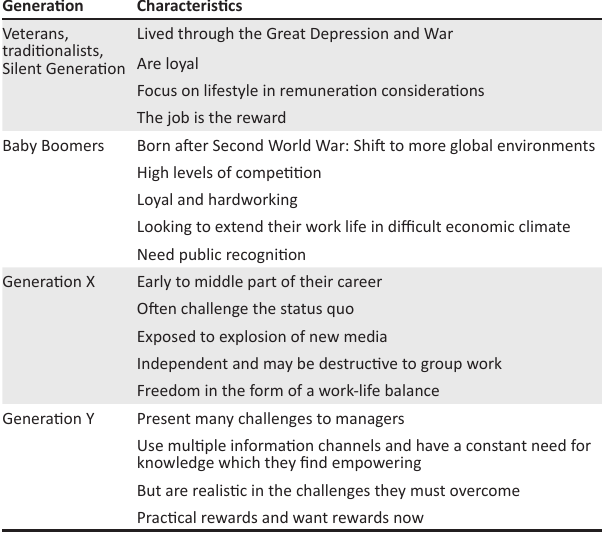
TABLE 1: Summary of workplace generation characteristics. Generation Characteristics Veterans, traditionalists,